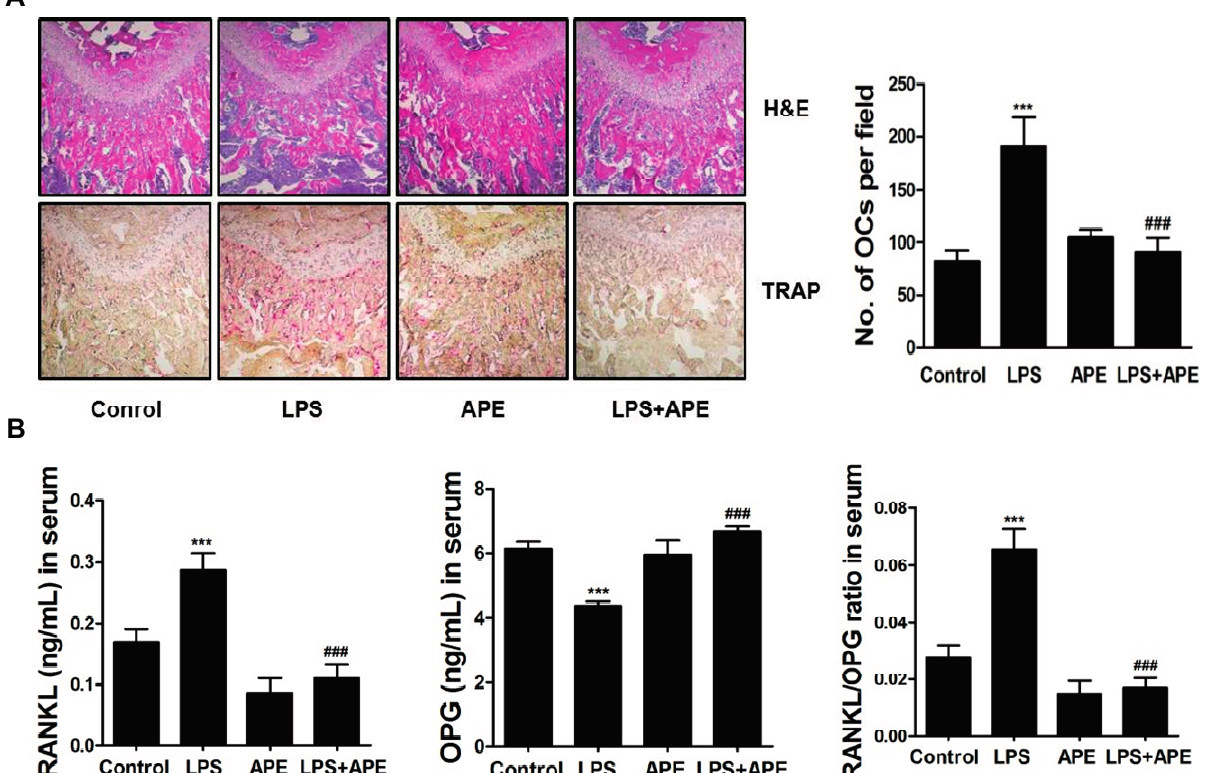
phosphatase (TRAP) (bottom). The number of osteoclasts per field of tissue was analyzed using the histomorphometric results (right); ( B ) Levels of receptor activator of nuclear factor kappa-B ligand (RANKL), osteoprotegerin (OPG), and the serum RANKL/OPG ratio of control, LPS-treated, Aconitum pseudo-laeve var. erectum (APE)-treated, and both LPS and APE-treated